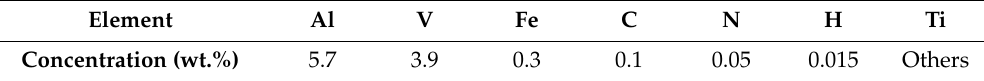
Figure 1. Schematic of the experimental setup. Table 1. Chemical composition of Ti–6Al–4V titanium alloy.